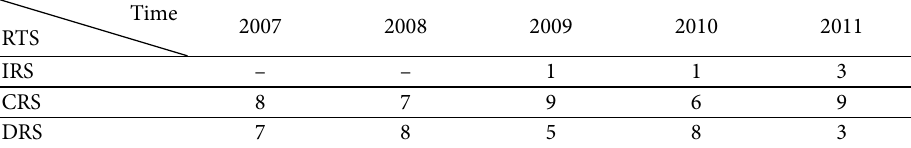
Table 6. 2007–2011 Returns to scale analysis statistics (unit: number of DMU)